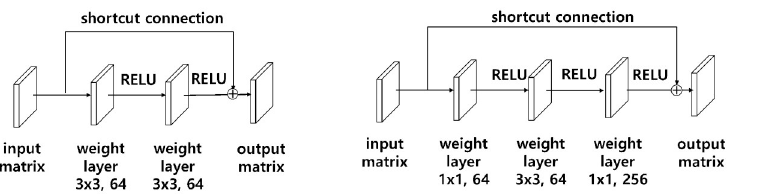
Fig 7. Bottleneck architecture. (a) A building block (b) A bottleneck building